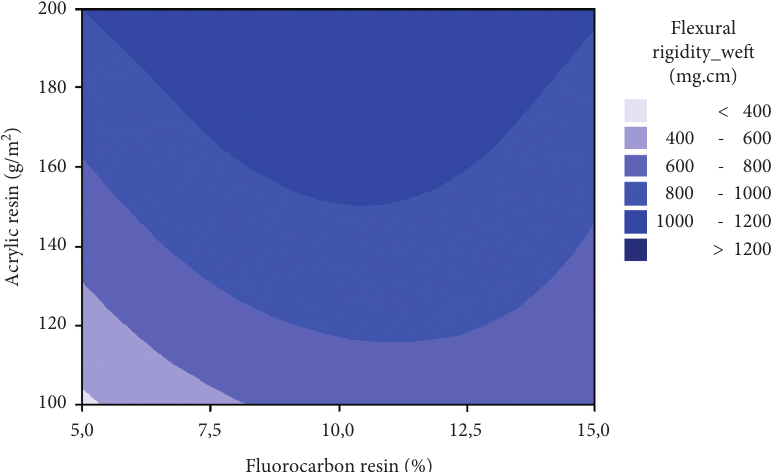
Figure 13: Contour plot for the weft flexural rigidity of the coated cotton-PES blended fabric.